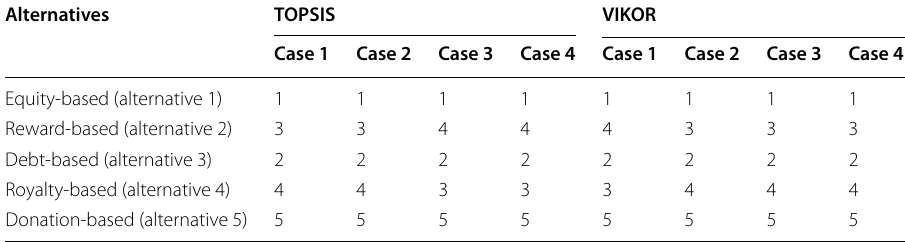
Table 26 Sensitivity Analysis with TOPSIS and